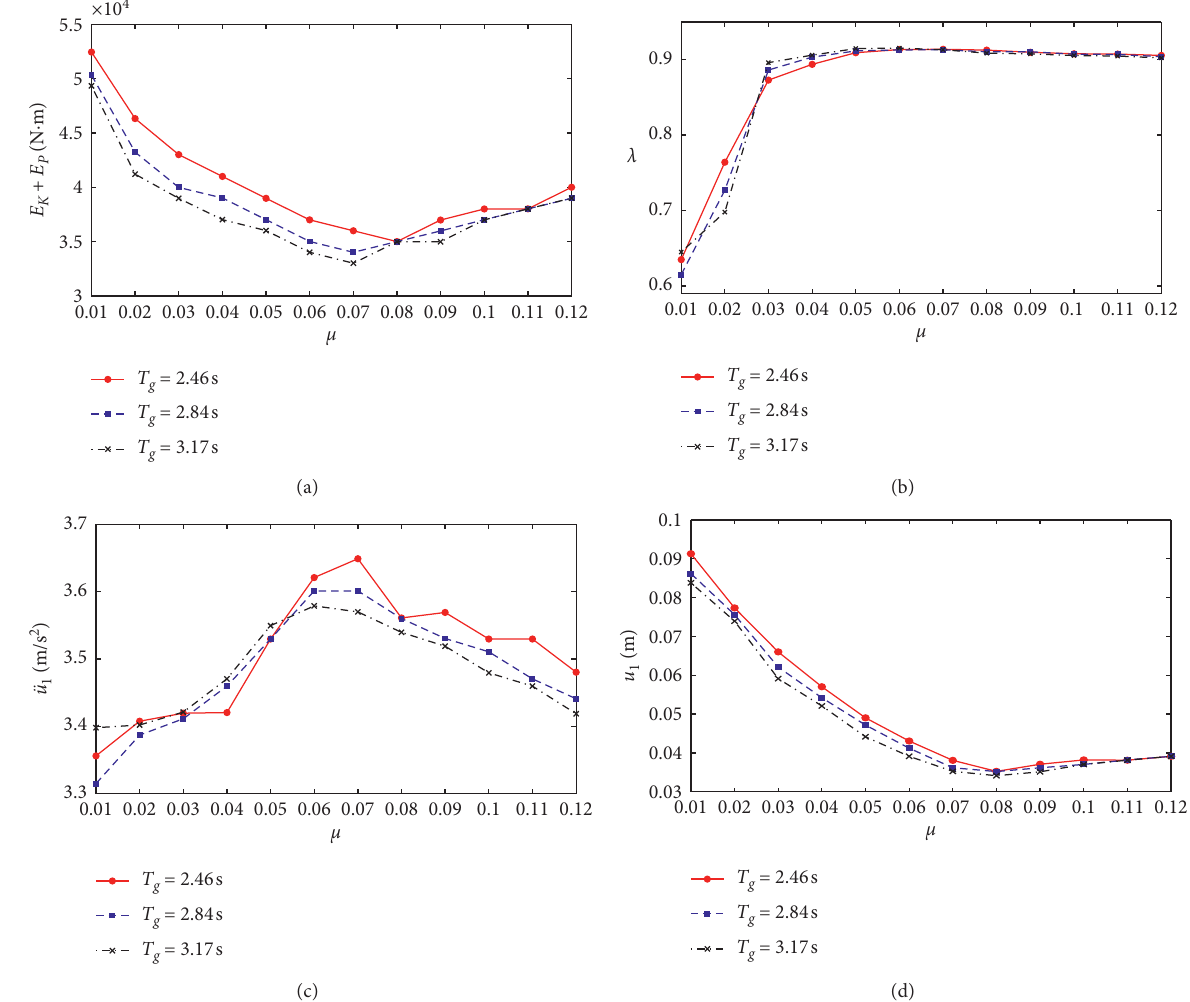
Figure 17: Seismic response amplitude (Taft, peak acceleration 0.3 g ). (a) Structural response energy; (b) energy consuming ratio; (c) acceleration amplitude of the main beam; (d) displacement amplitude of the main